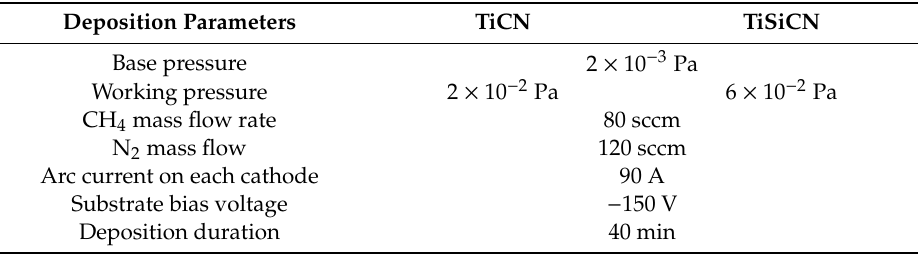
Table 1. Conditions for the developed